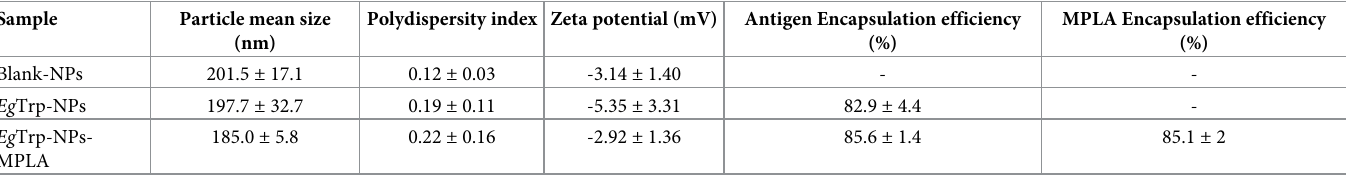
Table 1. Characterization of nanoparticles for their mean size, size distribution, Zeta potential, and the encapsulation efficiency for loaded proteins and MPLA. Sample Particle mean size